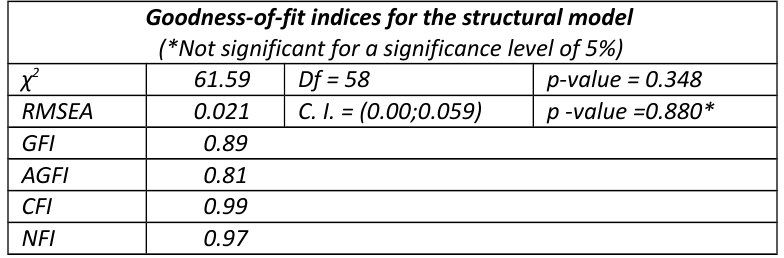
Table 4. Goodness-of-fit indices for the structural model